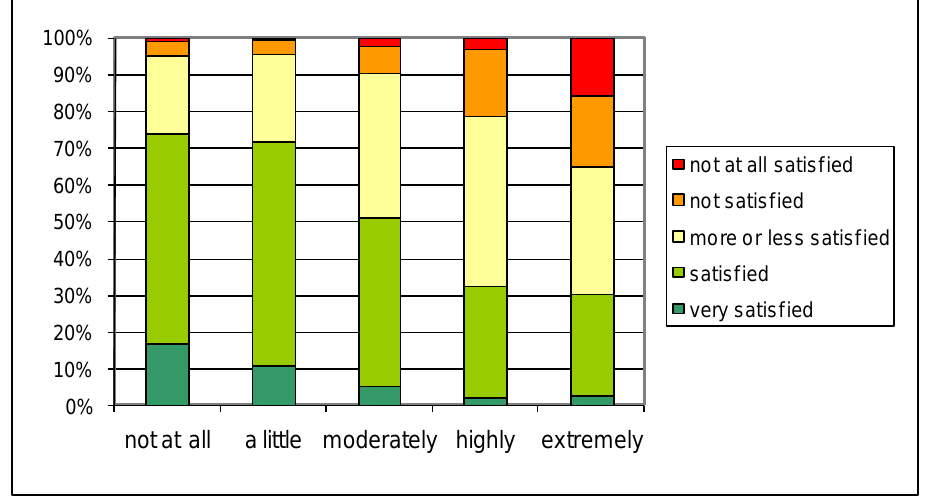
Figure 5. The influence of reported air traffic noise annoyance (Q2.1c) (horizontal) on global living quality in the neighborhood (Q1.1) (vertical).